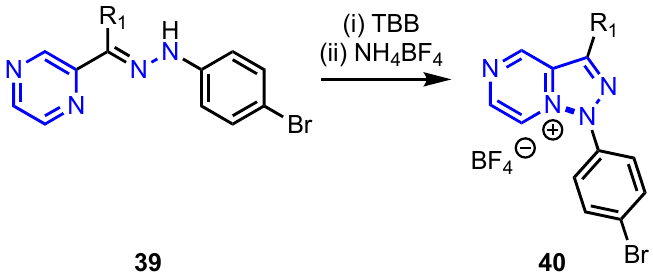
Scheme 8. Intramolecular cyclization of a 4-bromophenylhydrazone 39 forming triazolopyrazinium tetrafluoroborate 40 . (R 1 = alkyl or aryl.)